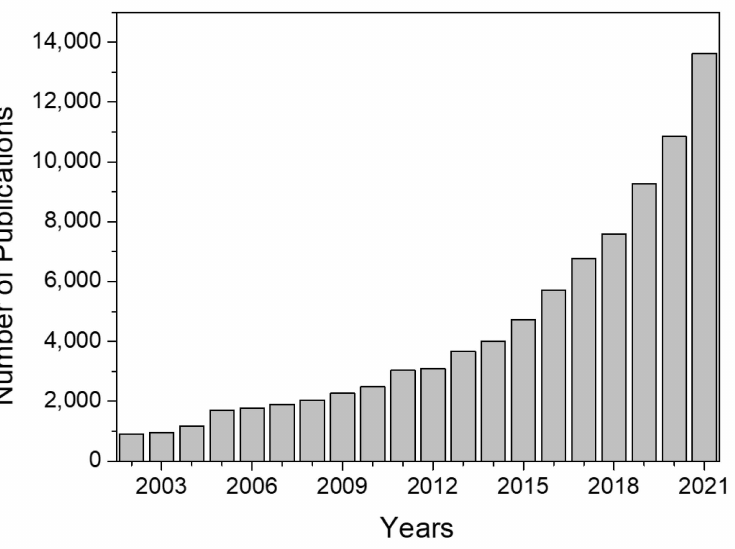
Figure 6. Evolution of the number of publications related to hydrogels. Data obtained from